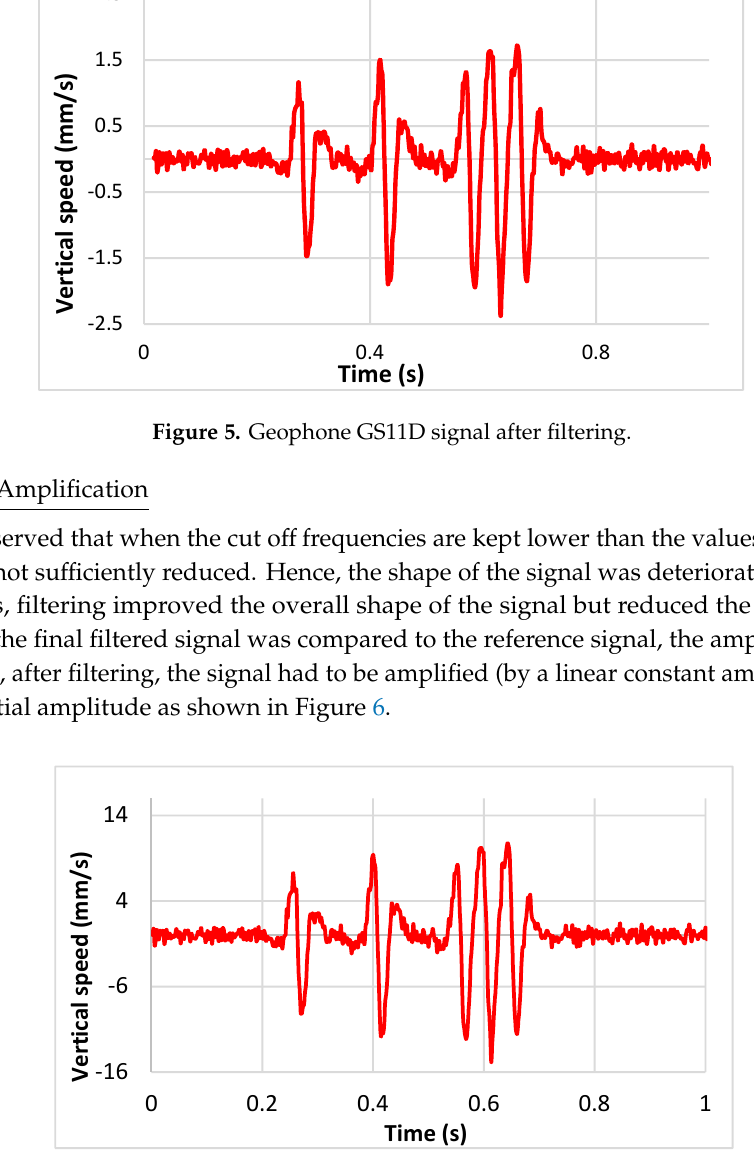
Figure 6. Signal amplification after filtering.